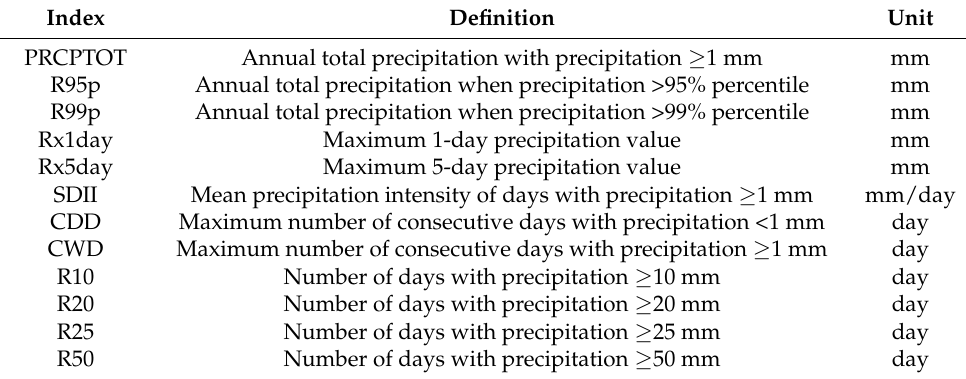
Table 1. Definitions of extreme precipitation indices used in this